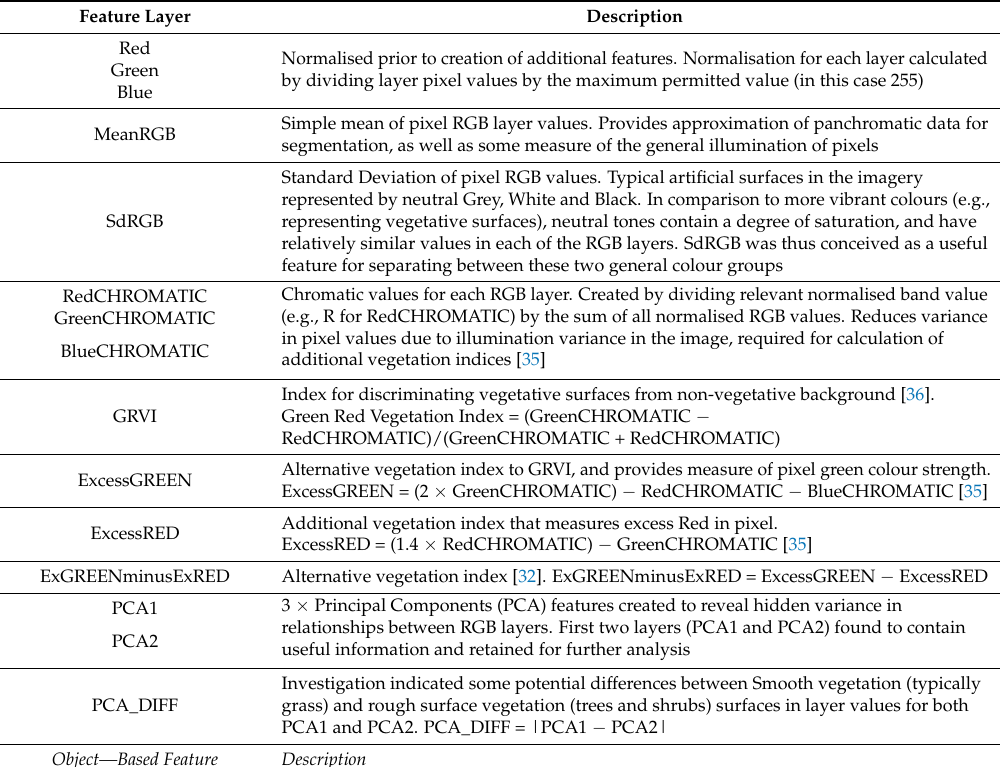
Table 3. Descriptions of spectrally-derived